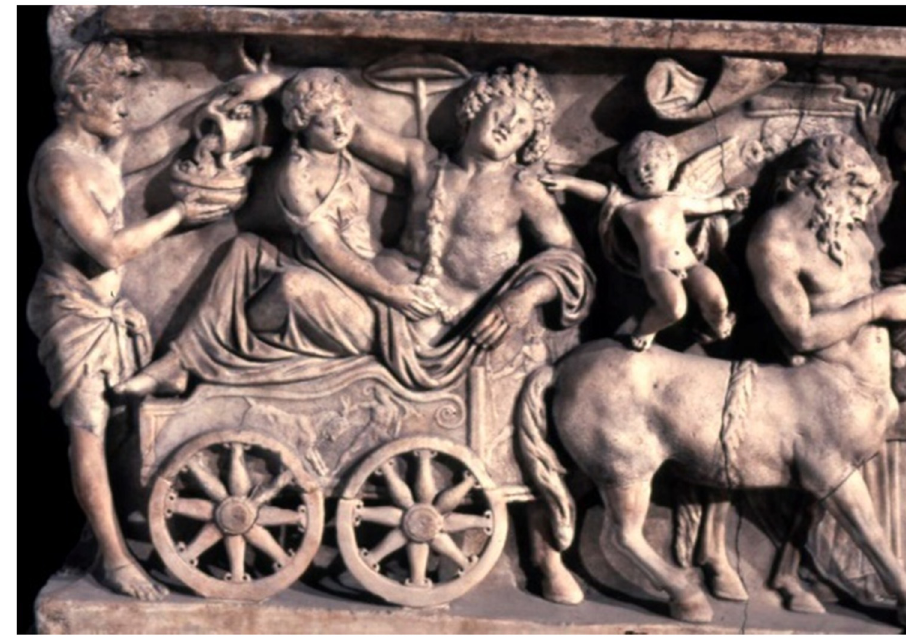
Figure 28: Sarcophagus, Dionysus and Ariadne . British Museum, London. Public Domain.